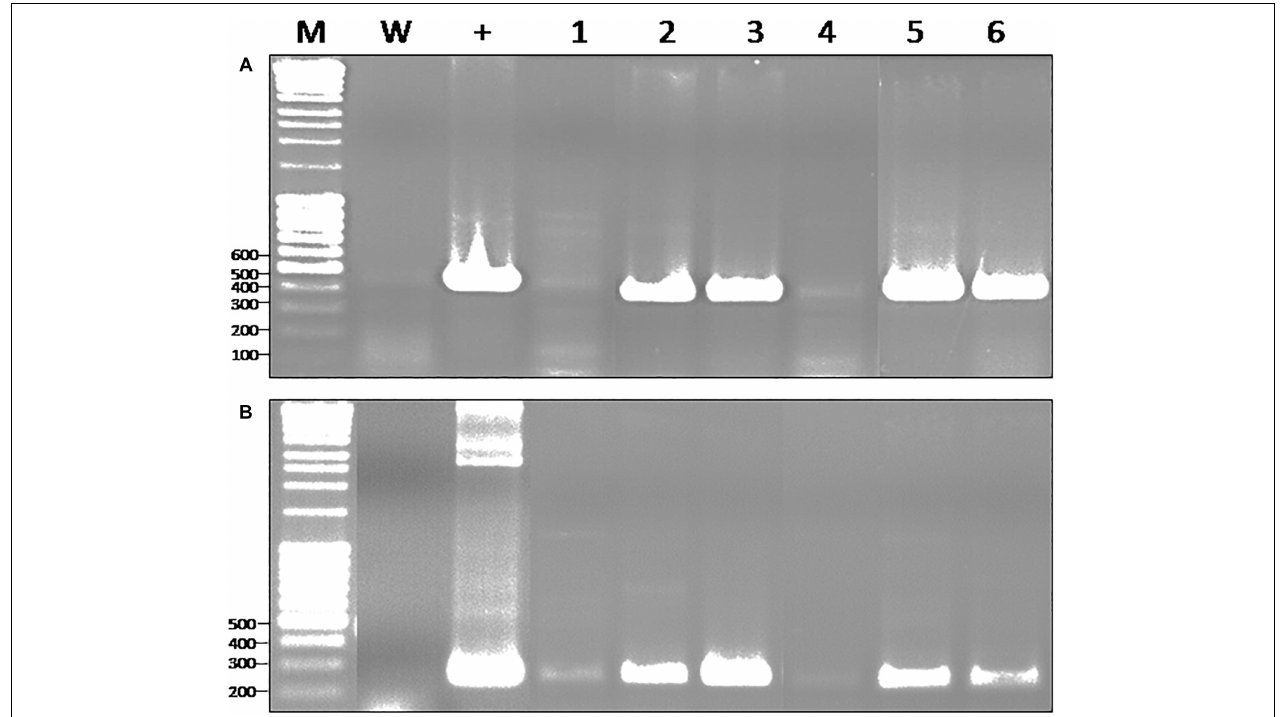
FIGURE 5 | RT-PCR exhibiting the capacity of recombinant TMV to infect and to move systemically into N. alata plant in 14 days. (A) Use of specific primers to TMV capsid protein gene (480 bp); (B) Use of specific primers to gfp (246 bp); M, Marker; W, water; +, RNA from N. benthamiana infected by TMV- wt (A) and agroinfiltrated by pMW388- gfp plasmid (B) ; 1 and 4, RNA from inoculated leaf with safety N. benthamiana extract at 5 days (1) and 14 days (4); 2 and 5, RNA from inoculated leaf with N. benthamiana extract infected by TMV- wt and agroinfiltrated by pMW388- gfp at 5 days (2) and 14 days (5) ; 3 and 6, RNA from pitcher attached to inoculated leaf with N. benthamiana extract infected by TMV- wt and agroinfiltrated by pMW388- gfp at 5 days (3) and 14 days (6) post inoculation. Parts of gels separated by a space were grouped together and lined up to facilitate the visualization of results. Any changes touching the quality of picture were applied to every pixel of each